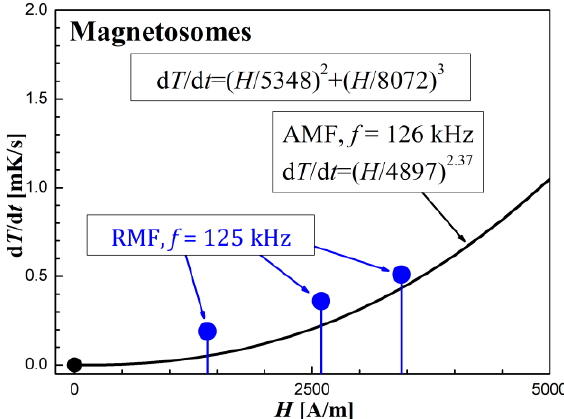
Figure 12. Comparison of the d T /d t dependence on the amplitude of the intensity H measured in rotating and oscillating magnetic fields in the Dextran FF sample.